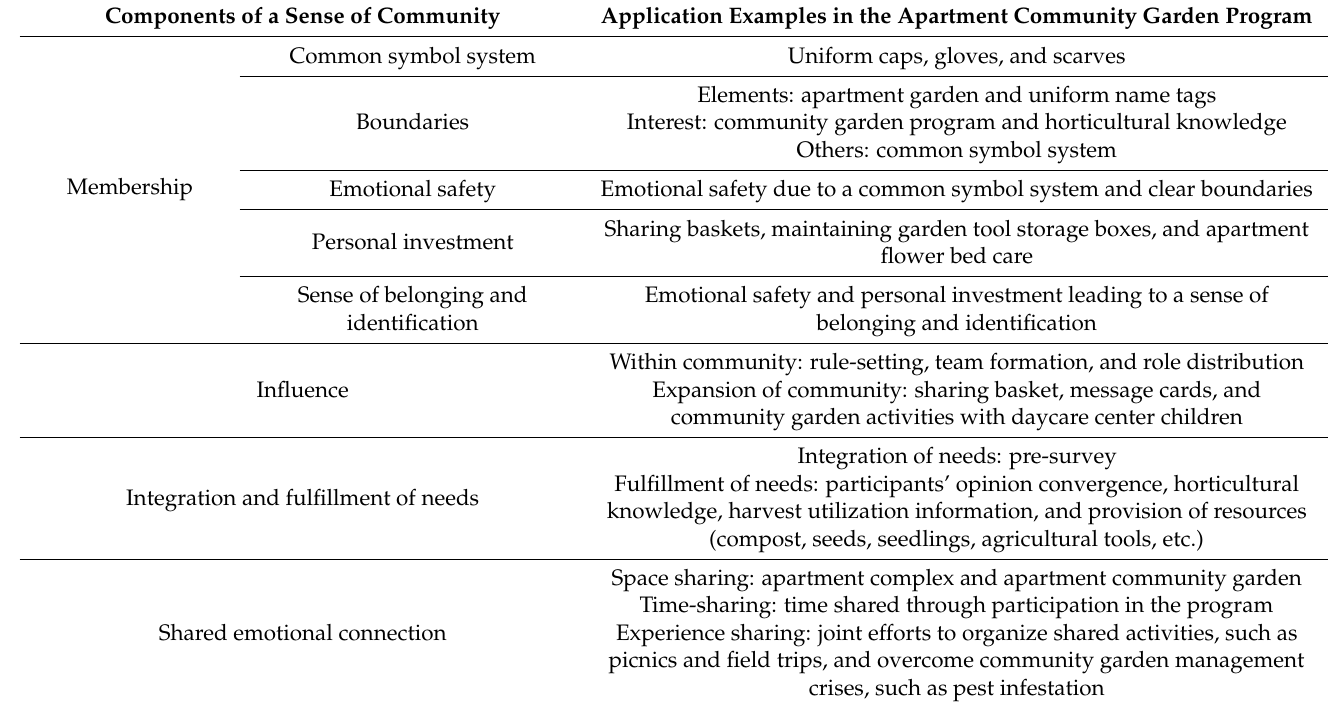
Table 3. Application of the sense of community theory of McMillan and Chavis [18] to the apartment community garden